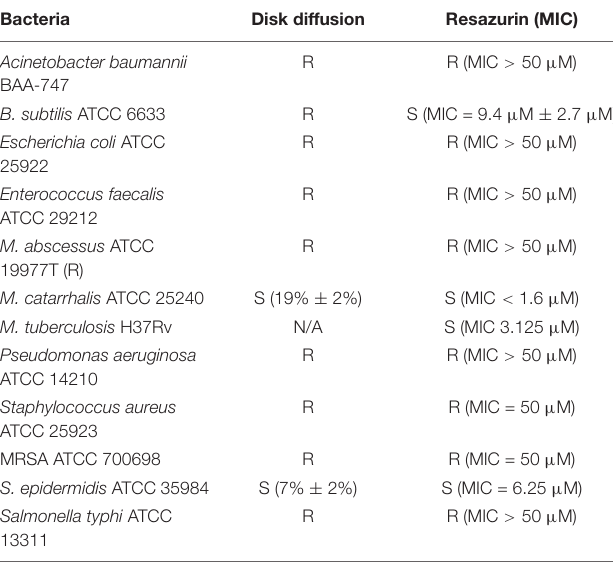
TABLE 3 | DDUG broth activity against a range of pathogenic bacteria.